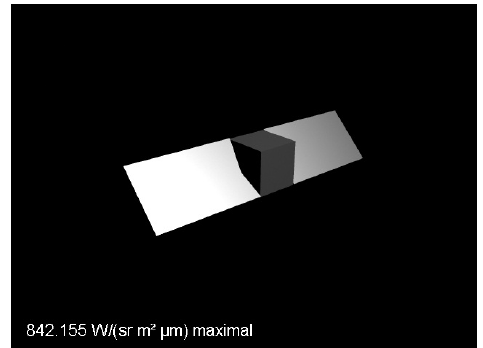
Figure 3: Camera simulation for a moon lander. The shadows are generated by using an irregular shadow map, see Figure 1. The triangle meshes of the different visible moon DEM tiles are put together, so that, only one continuous mesh without holes is rendered.